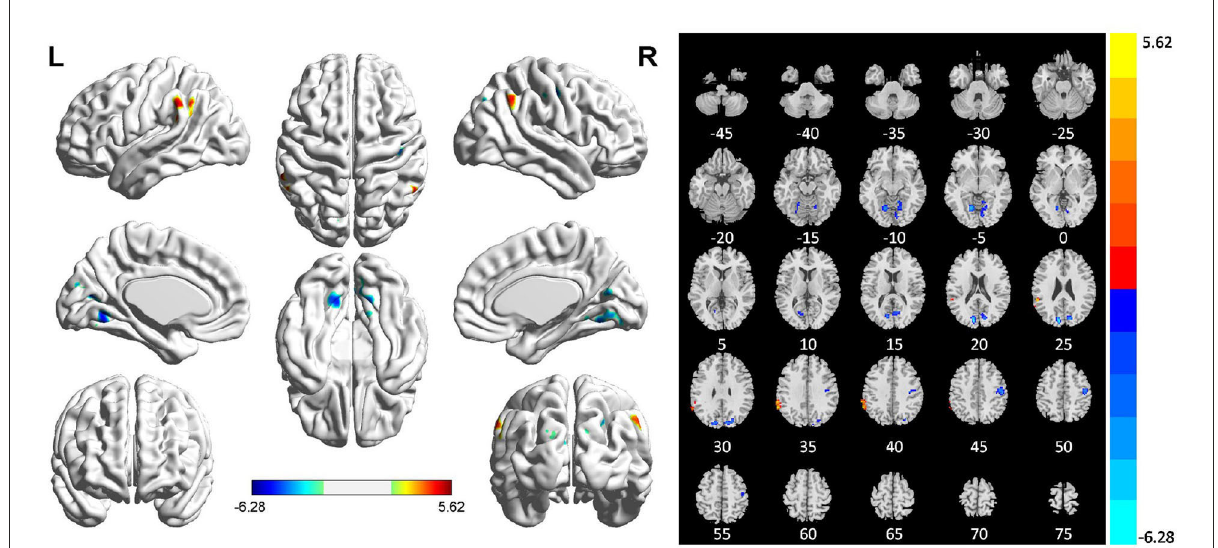
FIGURE2 Statistically significant differences between patients with post-stroke insomnia (PSI) and healthy controls are shown in a regional homogeneity (ReHo) map of the whole-brain with magnetic resonance imaging (MRI). Patients with PSI showed a significant ReHo increase in the left supramarginal gyrus (warm colors), as well as a decrease in the bilateral lingual gyrus, right cuneus, right precentral gyrus, and posterior central gyrus with decreased ReHo values (cold colors). A T-score bar is shown below and right. Red and blue denote increases and decreases in ReHo, respectively.